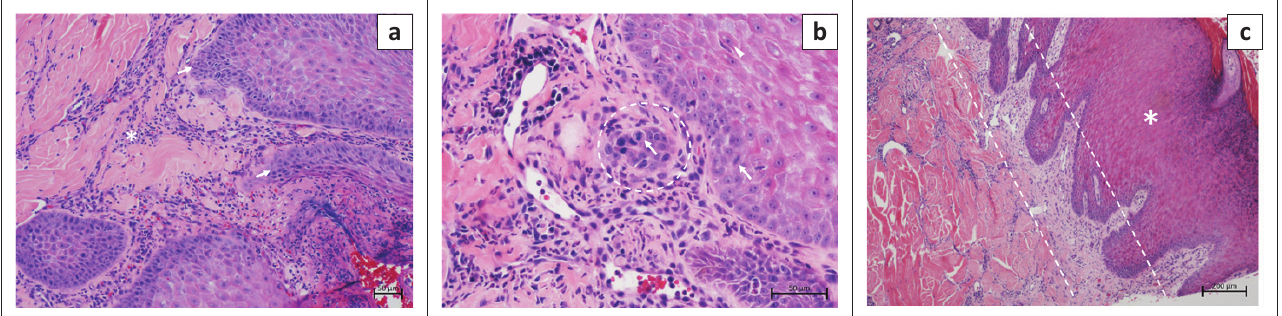
FIGURE 2: Histological features of the lesions. (a) Epidermal rete peg accentuation ( arrows ) and subepidermal perivascular inflammation ( asterisk ) (HE stain, x100 magnification). (b) Dyskeratosis ( arrowhead ), mitoses ( arrows ) and island of neoplastic epithelial cells below the basement membrane ( dashed circle ) (HE stain, x200 magnification). (c) Acanthosis ( asterisk ) and pale band of subepidermal laminar fibrosis ( area between parallel dashed lines ) (HE stain, x40 magnification).